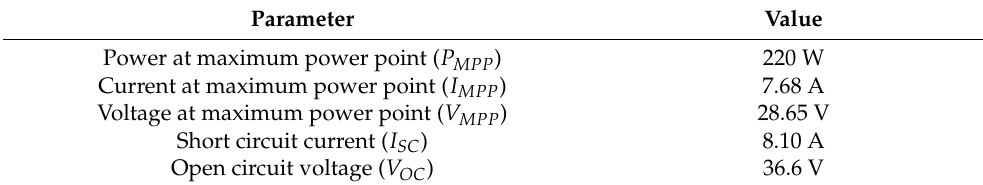
Figure 2. Examined PV system: ( a ) Physics picture of the PV strings, ( b ) Inverter’s internal circuit design, including the anti-PID functionality. A black box labels the first PV string, and a red box labels the second PV string. Table 1. Main electrical parameters of the examined PV modules at STC